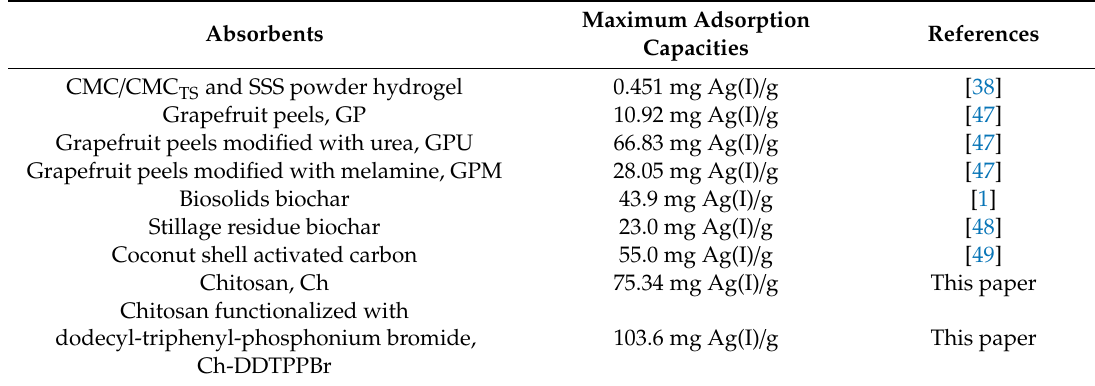
Table 4. Comparison of maximum adsorption capacities obtained for di ff erent adsorbents.